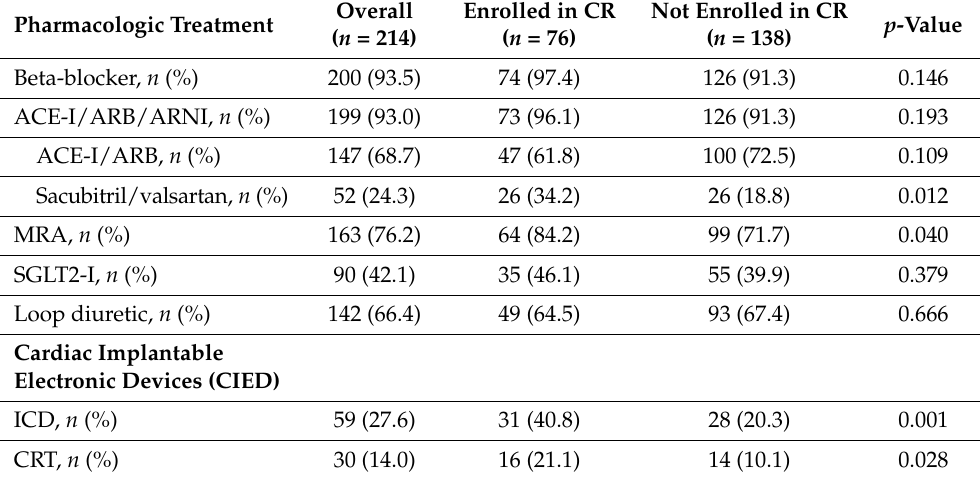
Table 3. Pharmacologic treatment and cardiac implantable electronic devices of the studied popula- tion according to participation in cardiac rehabilitation program.